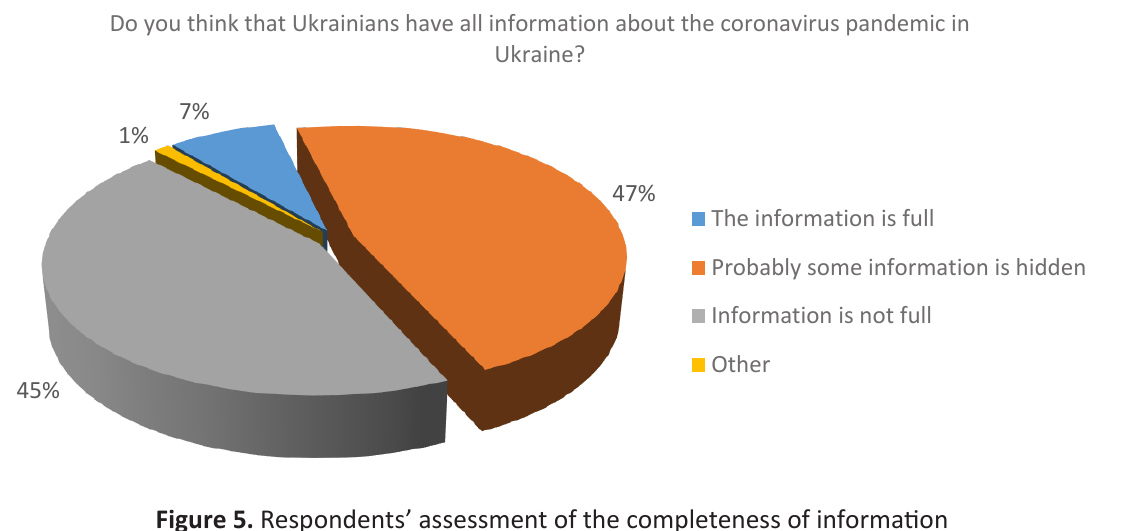
Figure 5. Respondents’ assessment of the completeness of